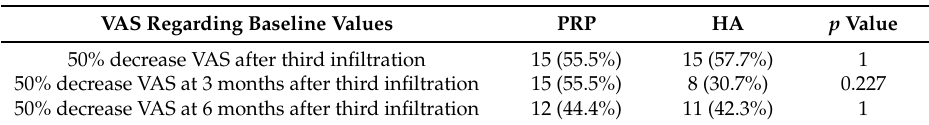
Table 7. Visual Analogue Scale (VAS) scores for the PRP group and the HA group during the study period regarding baseline values. 95% confidence interval.